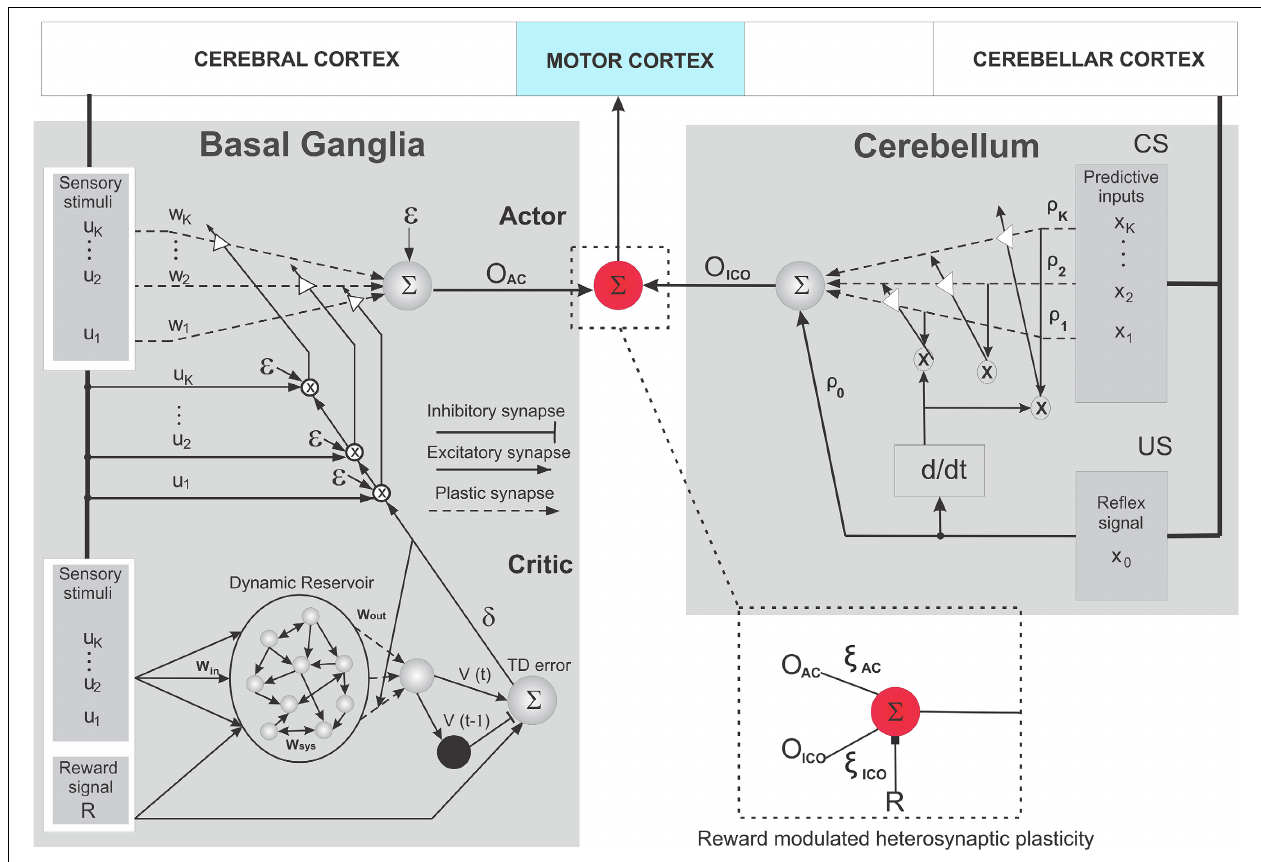
FIGURE 3 | Schematic wiring diagram of the combined learning neural circuit. It consists of the reservoir actor-critic RL based on TD learning (left) and the input correlation learning (ICO) (right) models. The critic here is reminiscent of the cortico striatal connections modulated by dopaminergic neural activity (TD error). The actor represents the neuromodulation process at the striatum, which reaches the motor thalamus by projections from GPi/GPe and SNr. The ICO learning system is constructed in a manner similar